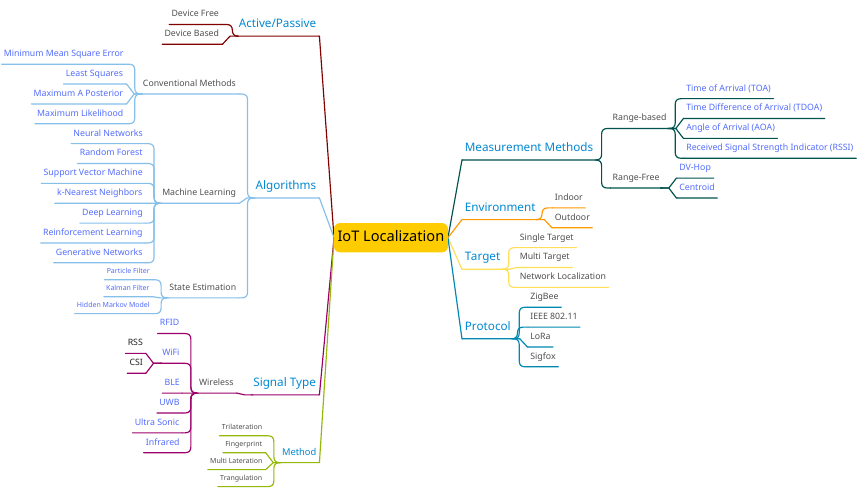
Figure 1. A high-level overview of the IoT localization classification.